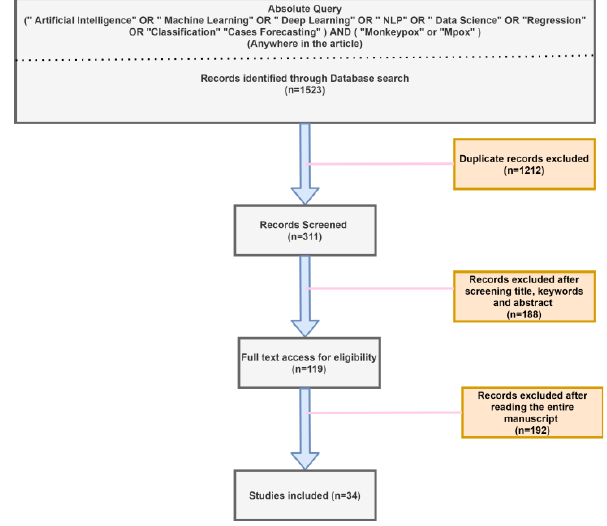
Figure 4. Article selection procedure using PRISMA methodology.